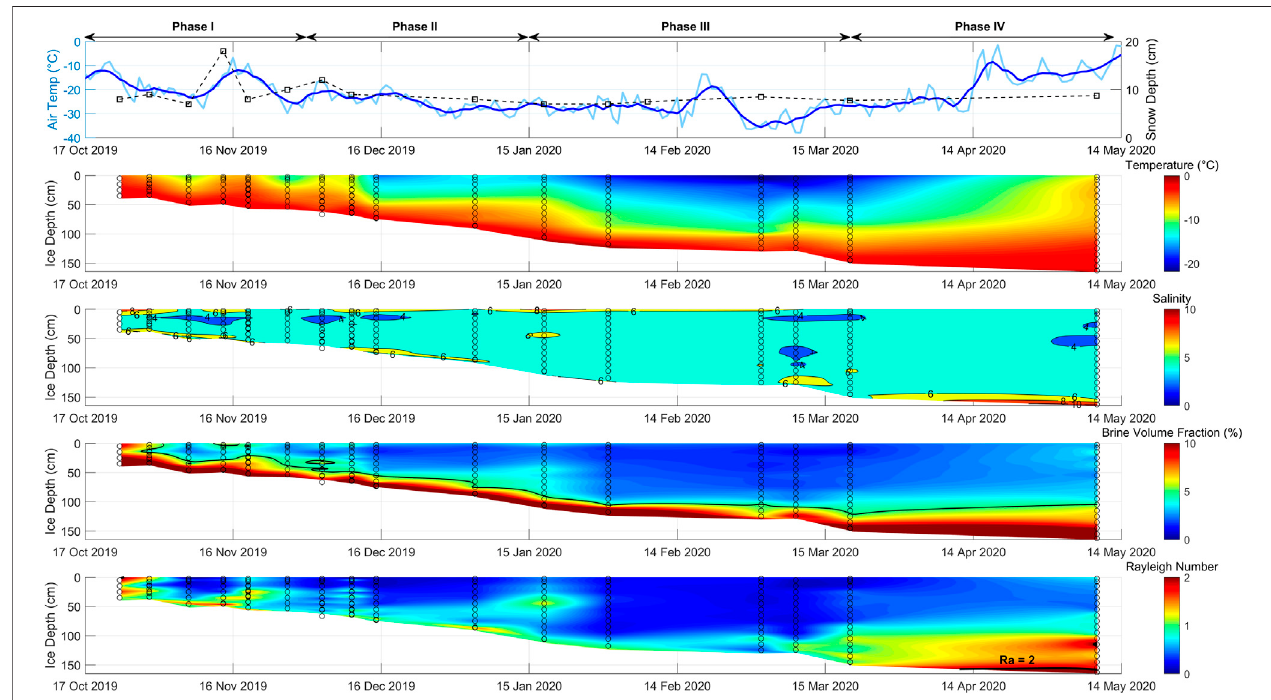
FIGURE3| Theevolutionoftemperature,salinity,brinevolumefraction( BVF ),andtheRayleighnumber( Ra )attheBGC1 fi rst-yearicesite.Thetoppanelshowsthe meandailyairtemperature(lightblueline)witha7-daycenteredmovingaverage(darkblueline)basedonRV Polarstern onboardmeasurementsandsnowdepth(dotted black line). The black circles represent ice sample midpoints, where values were stored to generate the interpolated fi elds. The thick black line in the BVF subplot indicatesthe5% BVF contourandhencetheassumedboundarybetweenimpermeable( BVF < 5%)andpermeable( BVF ≥ 5%)ice.The BVF colorbariscappedat 10%. The Ra color bar was capped at 2, which represents the minimum theoretical threshold for brine gravity drainage to occur based on the temperature and salinity. For the fi rst coring date (24 October 2019), only the core with the maximum Ra number is shown.